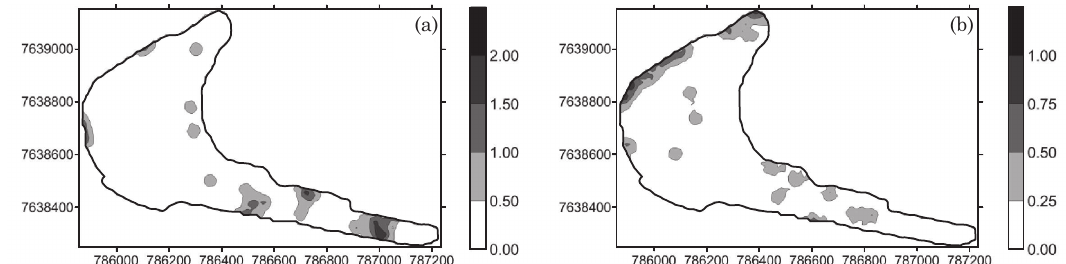
Figure 4. Relative improvement (%) of the accuracy due to the use of optimized additional samples: chemical (a) and physical (b) properties.